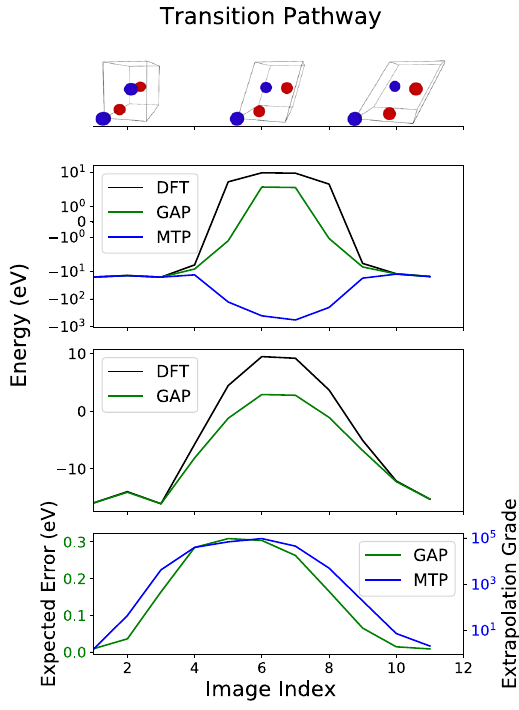
Fig. 4 GAP and MTP predictions for the transition pathway. Since there were no con fi gurations in the training set along the middle of the path, the MTP prediction is purely extrapolative and presents a false, deep, local minimum. Because of its tight regularization, the GAP prediction for this transition is reasonable. It underestimates the barrier signi fi cantly due to the lack of training data, but does not introduce a false minimum. Note the symmetric log scale (linear between − 1 and + 1) on the y -axis in the upper plot. Above the plots are con fi gurations along the pathway. The upper Pd atom (blue) at index 1 moves further into the page as the unit cell distorts. The furthest Ag atom (red) simultaneously moves out of the page. The lowest panel plots the expected variance of the GAP model and the extrapolation grade of the MTP model. Predictive variance is essentially the expected error per atom (in eV) along the transition pathway and the extrapolation grade is a dimensionless quantity indicating that if it exceeds ~10, then a con fi guration must be added to the training set because the prediction of its energy is not